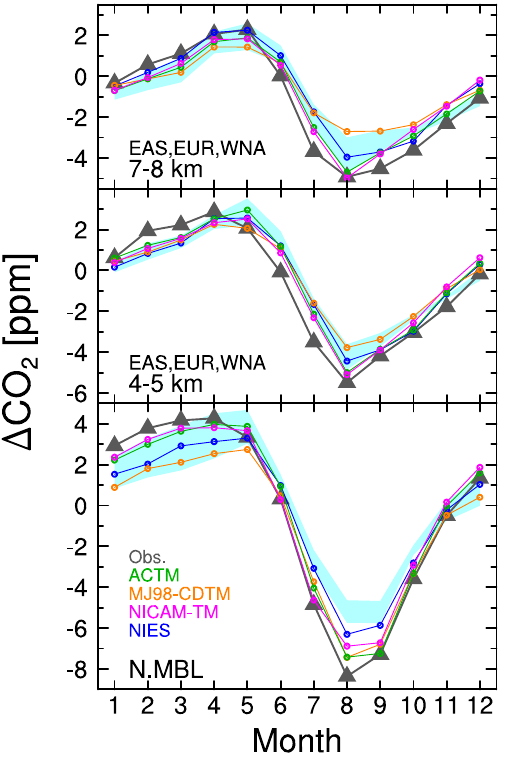
Fig. 7. Monthly mean variations of 1 CO 2 in the northern area for 2007. Data are averages of seasonal variations at six marine bound- ary layer (MBL) sites located between 20 ◦ N and 70 ◦ N for N. MBL (bottom panel) and at 4–5km (middle panel) and 7–8km (top panel) over the northern area, as aggregated from East Asia (EAS), Europe (EUR) and western North America (WNA). Gray triangles with lines show the results derived from CONTRAIL/GLOBALVIEW- CO 2 . Circles with lines are simulated results from Flux2: ACTM (green), MJ98-CDTM (orange), NICAM-TM (magenta), and NIES (blue). Cyan shade shows range of the simulated results from Flux1.